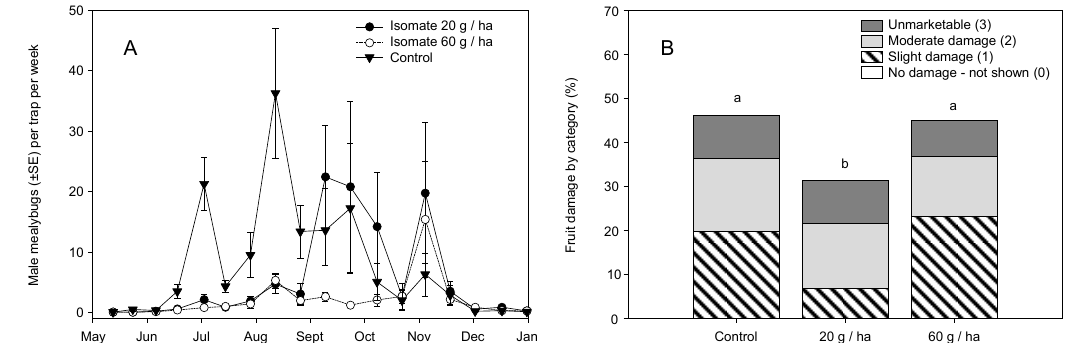
Figure 2. 2004 field studies showing ( A ) season-long adult male Pl. ficus captures (mean ± SEM) in pheromone-baited traps in plots with Isomate dispensers (ShinEtsu) hung at rates of 20 and 60 g (AI) per ha and ( B ) categorical ranking of mealybug damage to fruit clusters at harvest time (different letters above each bar represent significant differences, pairwise comparisons using an experiment-wide error rate at p < 0.016). The second 2004 trial compared two Isomate loads (4.1 and 8.3 g / ha), CheckMate Flowable (32 g / ha), and CheckMate dispenser (33.3 g / ha). For trap captures, the Isomate and CheckMate materials were compared separately to the control. The two Isomate rates showed no treatment effects on season-long male captures ( χ 2 = 0.115, df = 2, p = 0.891) with no effect of sample date ( χ 2 = 0.357, df = 1, p = 0.551) or treatment × date interaction ( χ 2 = 0.312, df = 2, p = 0.732) (Figure 3A). Season-long captures of males with Control CM spray 32 g / ha CM dispenser 33.3 g /